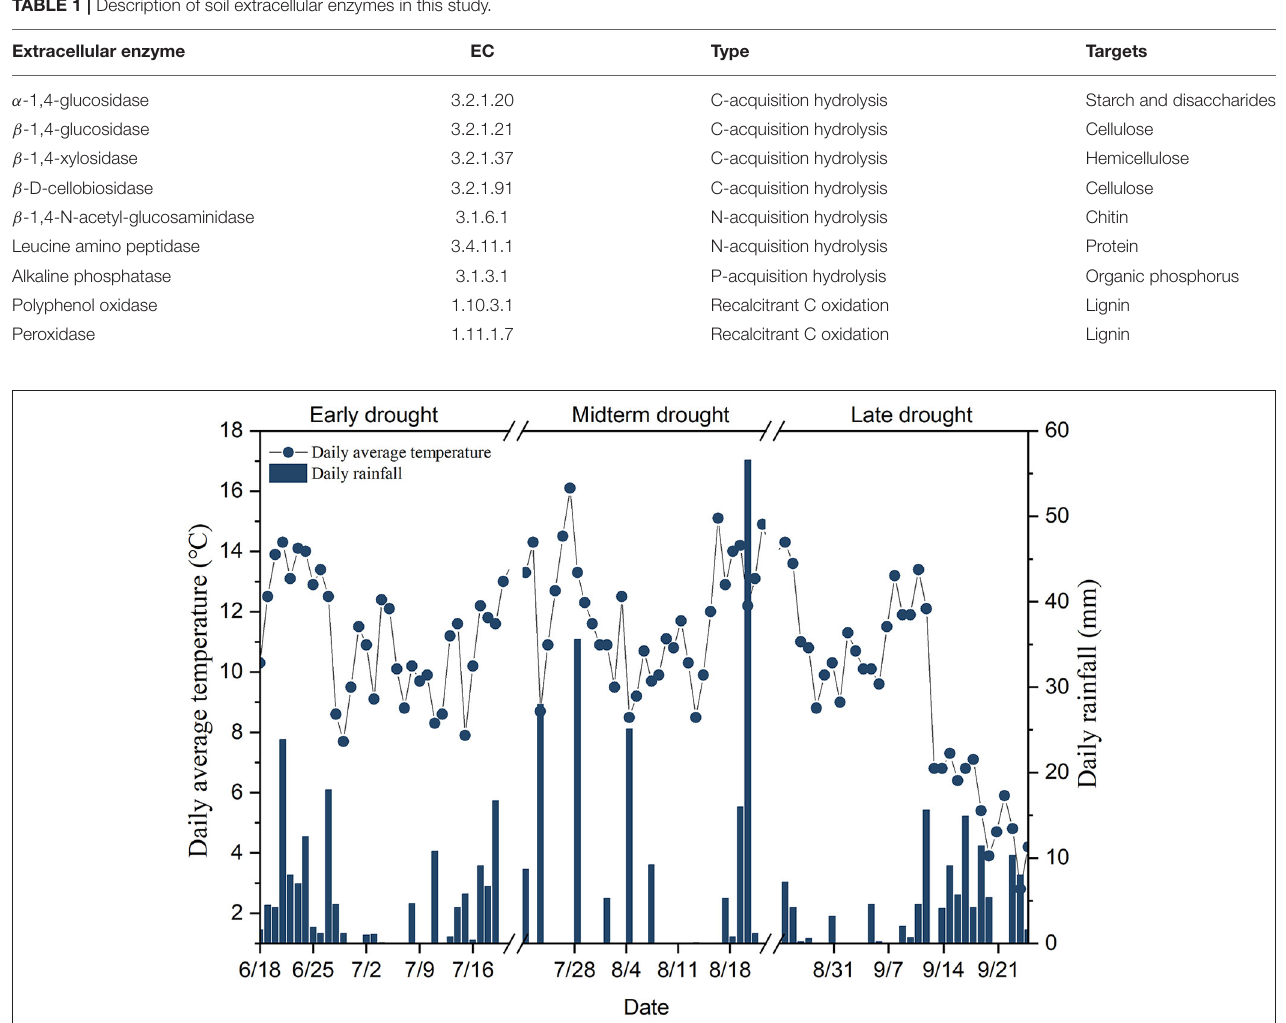
FIGURE 1 | Average daily temperature and precipitation of experiments in